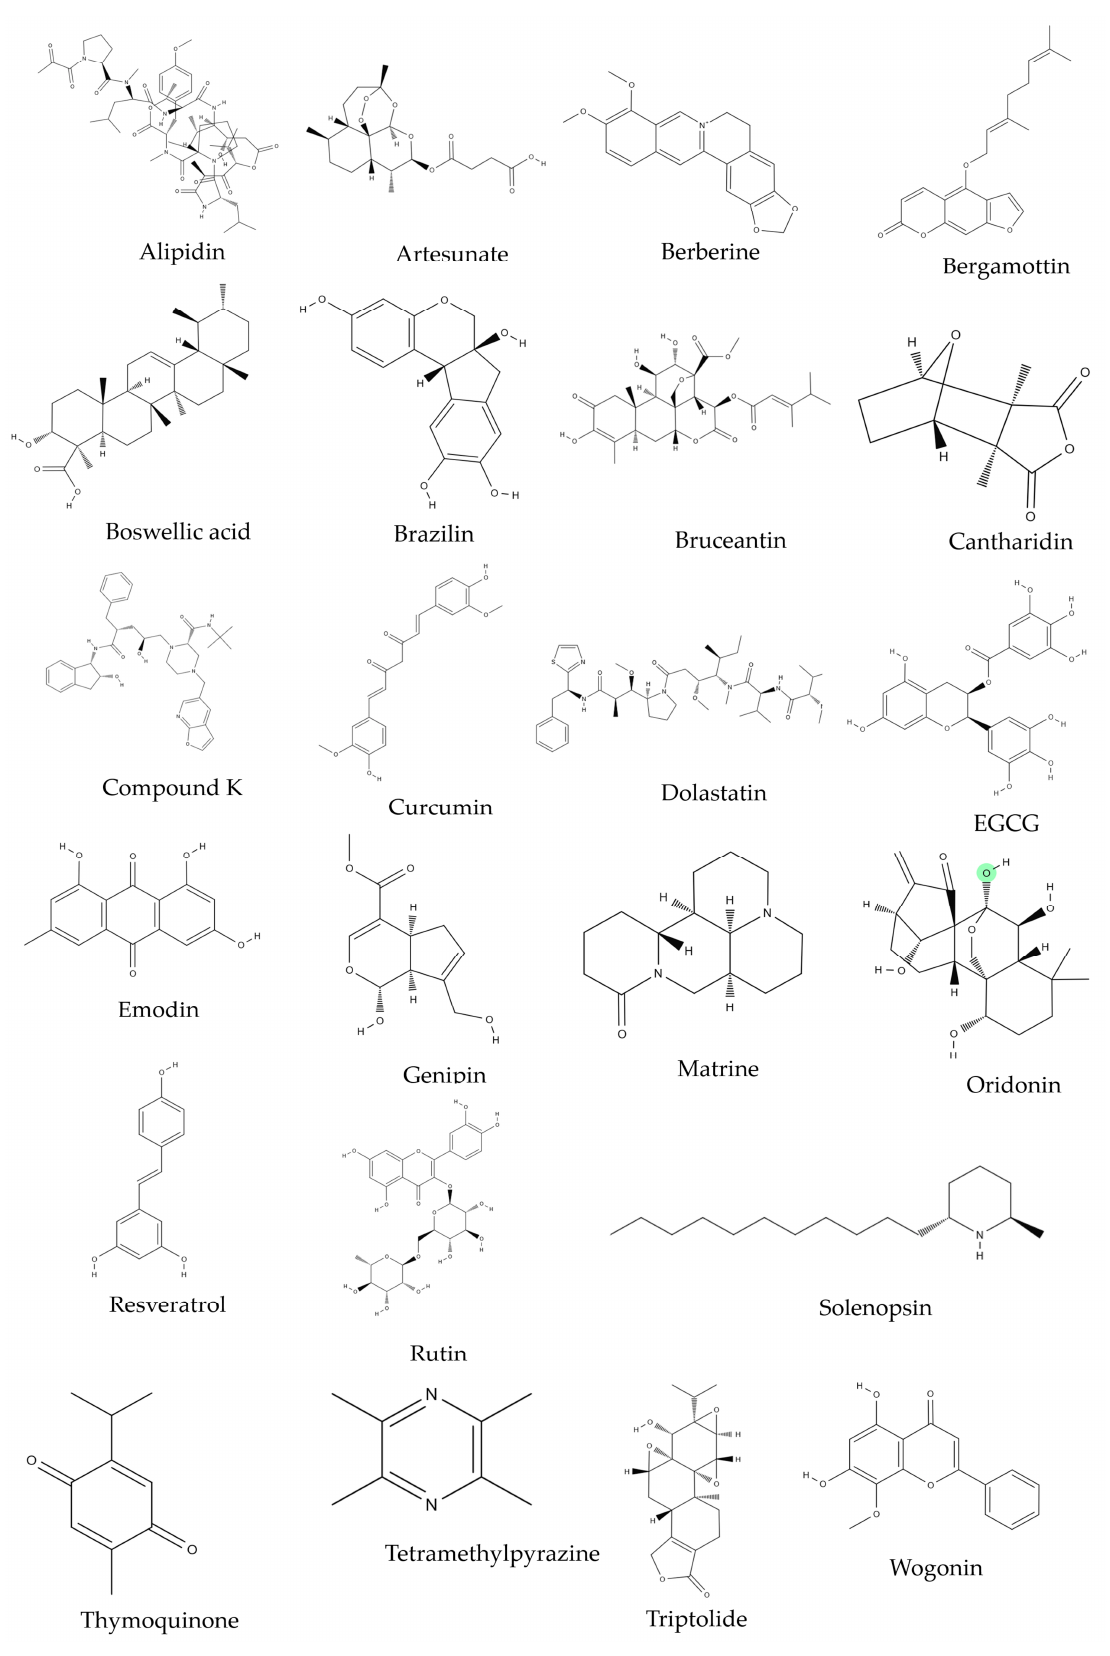
Figure 5. The chemical structures of phytochemicals which demonstrated anti-MM efficacies in vitro.